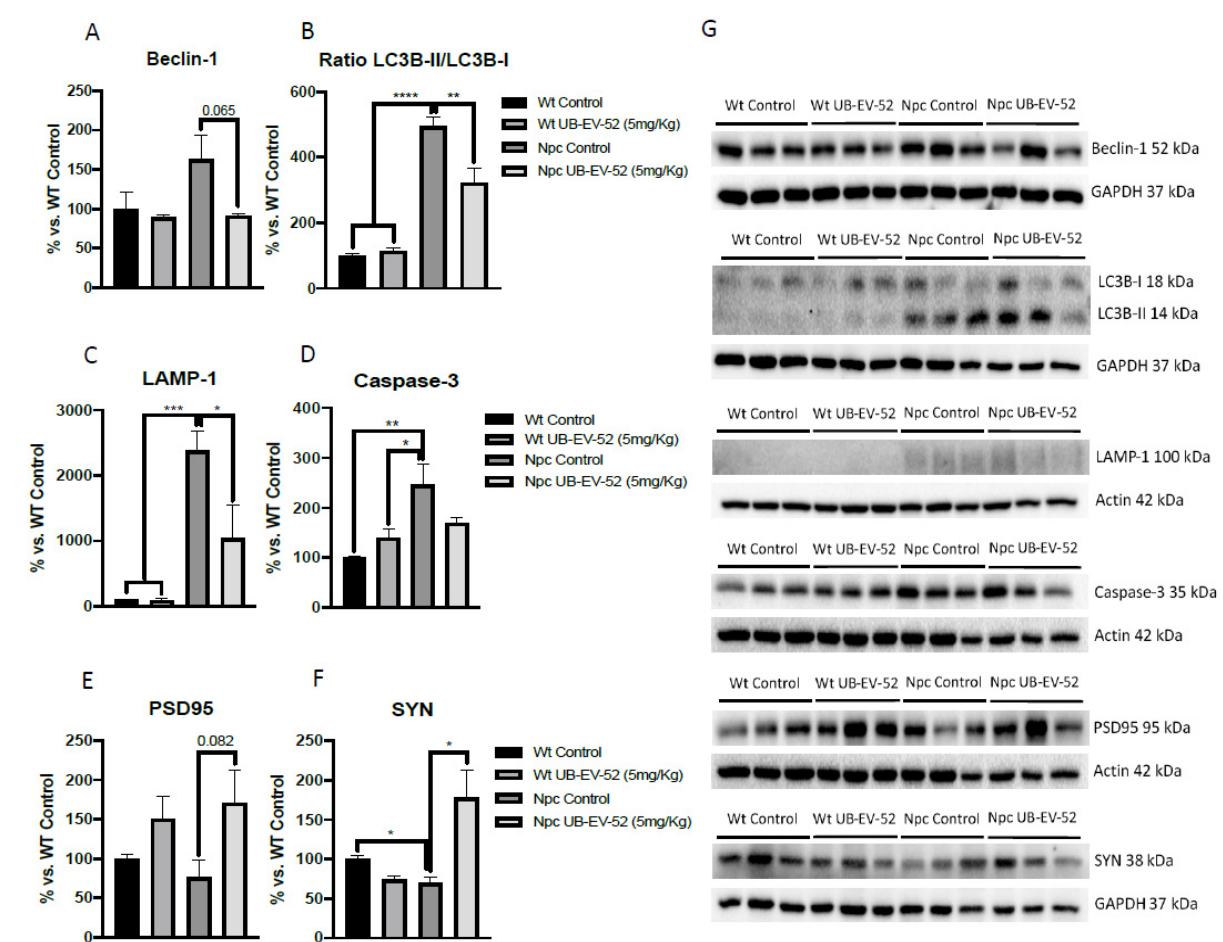
Figure 5. Quantifications and representative Western blot for beclin-1 ( A – G ), ratio LC3B-II/LC3B-I ( B – G ), LAMP-1 ( C – G ), caspase-3 ( D – G ), PSD95 ( E – G ) and SYN ( F , G ) from hippocampal tissue in females and males. Bar graphs values are 100% adjusted for Wt control protein levels. Values are mean ± standard error of the mean (SEM); ( n = 6 for each group). * p < 0.05; ** p <0.01; *** p <0.001; **** p <0.0001.